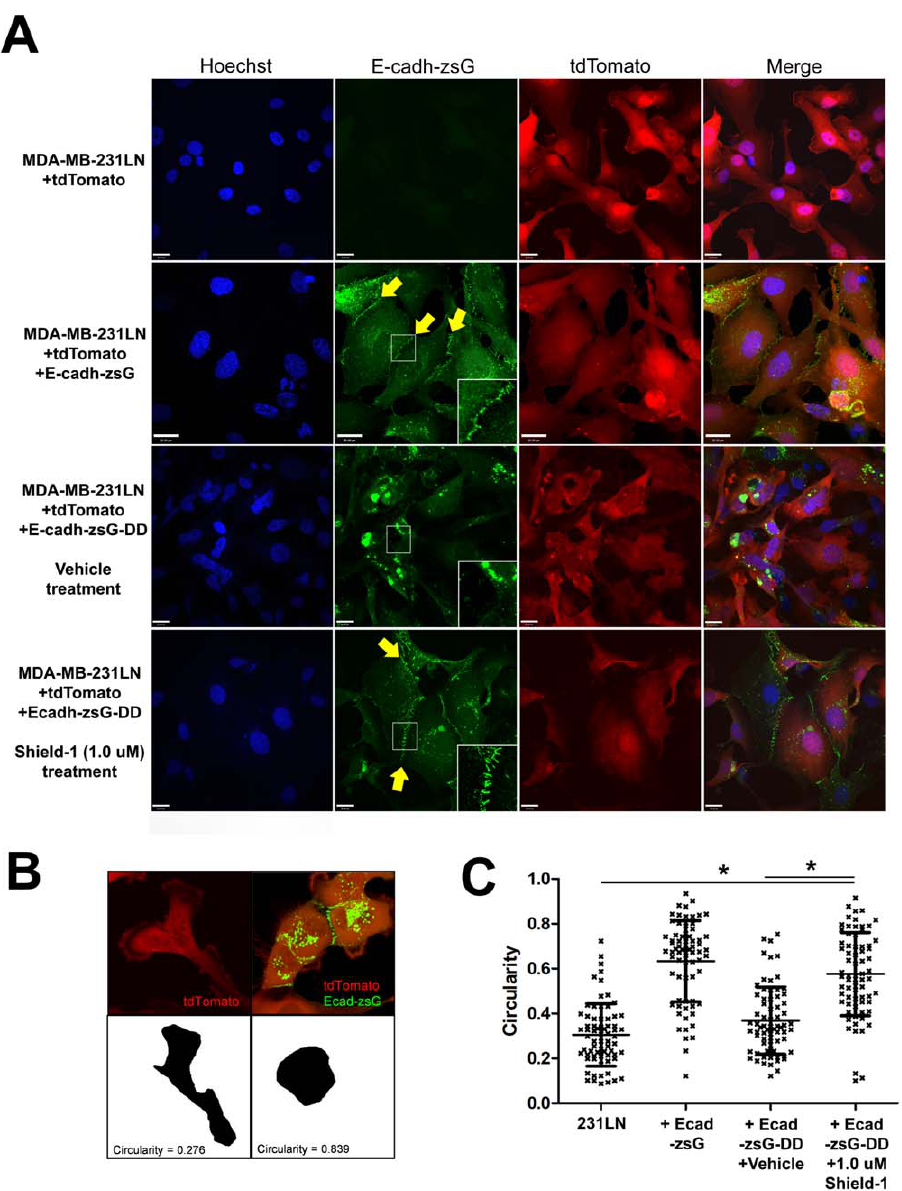
Figure 3. Characterization of tunable E-cadherin-zsG-DD protein expression in 231LN cells invitro . A) Representative images of 231LN cells expressing fluorescent E-cadherin chimeras. Cell nucleus as stained by Hoechst (blue), E-cadherin-zsGreen (green), and tdTomato to highlight the cytoplasm (red) reveal the changes in cell morphology when E-cadherin is over-expressed (row 2) or induced with Shield-1 for 12 hours (row 4) compared to control (row 1) or un-induced cells (row 3). Arrows (yellow) highlight junctions formed by Shield-1-stabilized E-cadh-zG-DD. Scale bars are 20 m m. Insets show magnified view (250%) of cellular junctions. B) Examples of circularity measurements of representative 231LN cells (left) and 231LN cells expressing E-cadh-zsG-DD treated with 1.0 m M Shield-1 (right). C) Circularity measurements to assess a mesenchymal vs. epithelial morphology in cells described above. N=70 per group, * denotes p , 0.01 between groups, 2-way ANOVA. doi:10.1371/journal.pone.0030177.g003 (Figure 6, Movie S3). Micrometastatic colonies of 231LN cells, identified by virtue of their cytoplasmic tdTomato fluorescence, were assessed for changes in zsGreen signal subsequent to intravenous Shield-1 administration (Figure 6D). At final Shield- 1 concentrations ranging from an estimated 0.2–1.0 m M , an initial and rapid accumulation of zsG-DD protein was observed in the cytoplasm of 231LN cells (Figure 6A–C) while exhibiting no observable toxic effects on avian embryo viability. The time to attain maximal fluorescence and the degree of maximal fluores- cence was Shield-1 concentration-dependent (Figure 6D), and was